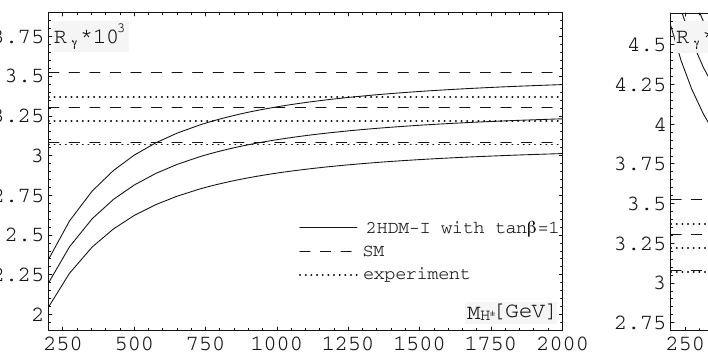
Fig. 17 BR ( B − → X s γ) as a function of M H ± for Model I ( left ) and Model II ( right ), at two values of tan β . Solid and dashed lines corre- spond to the NNLO 2HDM and SM predictions, respectively. (Shown